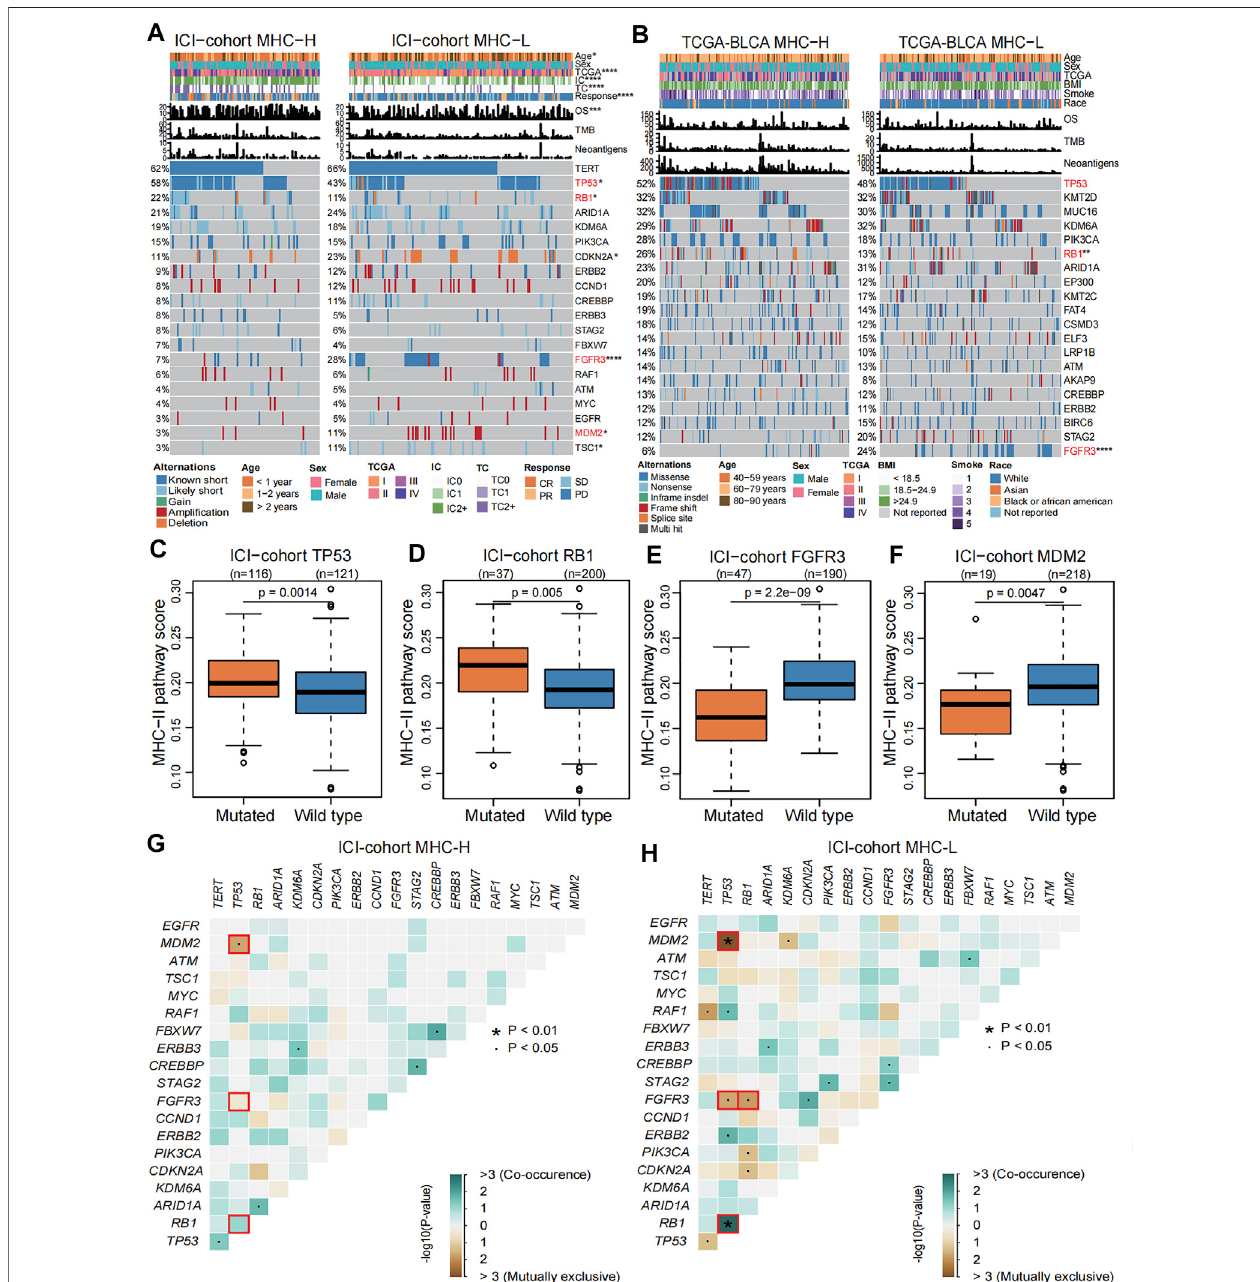
FIGURE6| GenomiclandscaperelatedtoMHC-IIsignature. (A) Comparisonofthedifferencesinthemutationstatusinthetop20geneswithmutations,diagnosis years(age),sex,TCGAstage,PD-L1expression (IClevelandTClevel),immuneresponse,OS,TMBandTNBbetweenMHC-H(left)andMHC-Lgroups(right)intheICI- cohort. Genes were ranked by mutation frequency (left panel). The mutation frequencies of TP53, RB1, FGFR3, and MDM2 genes were signi fi cantly different between twogroups, which aremarked withred font.*P < 0.05, **P < 0.01,***P < 0.001, and****P < 0.0001. (B) Comparison ofthedifferences inthemutation status inthe top 20geneswithmutations, age,sex,TCGA stage, BMI, smoking status,race, OS,TMB and TNBbetweenthe MHC-H (left) and MHC-L groups(right)in TCGA-BLCA cohort. Genes were ranked by mutation frequency (left panel). The mutation frequencies of TP53, RB1, and FGFR3 genes were signi fi cantly different between two groups, which are marked with red font. *P < 0.05, **P < 0.01, ***P < 0.001, and ****P < 0.0001. C-F. Boxplots show that TP53 (C) and RB1 (D) gene mutations were signi fi cantly correlated with high MHC-II signature in the ICI-cohort (Mann Whitney U test, P = 0.0014, P = 0.005, respectively), while FGFR3 (E) and MDM2 (F) gene mutations are signi fi cantly correlated with low MHC-II signature in the ICI-cohort (Mann Whitney U test, P = 2.2e-09, P = 0.0047, respectively). G-H. Concurrence (blue) and mutual exclusion (brown) between high frequency mutation genes (the top 20 genes with mutations) in MHC-H (G) and MHC-L (H) groups in the ICI-cohort. · P < 0.05, *P < 0.01.